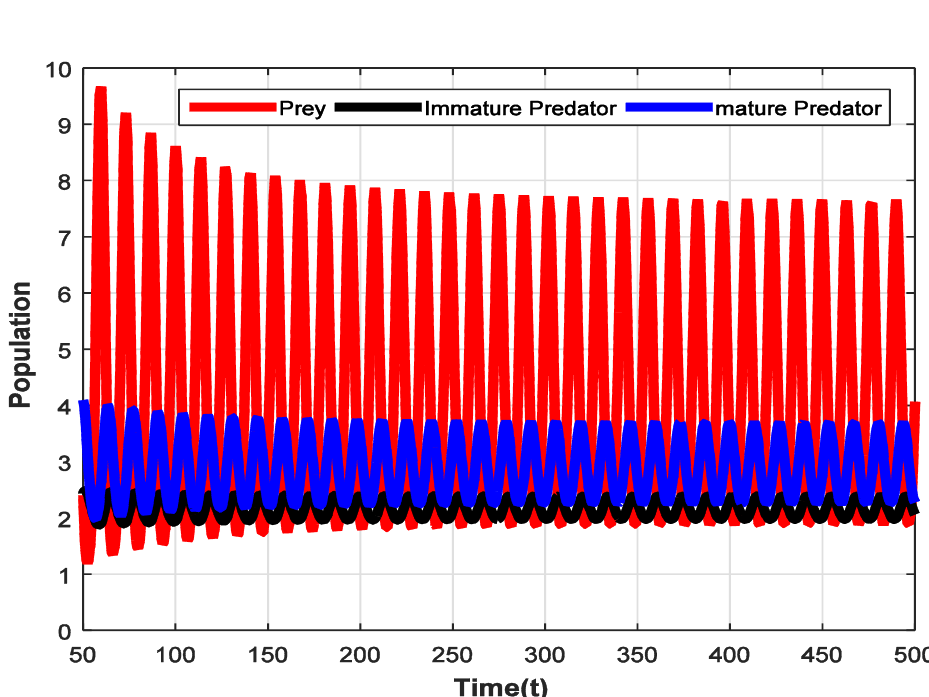
Figure 5. Population graph for